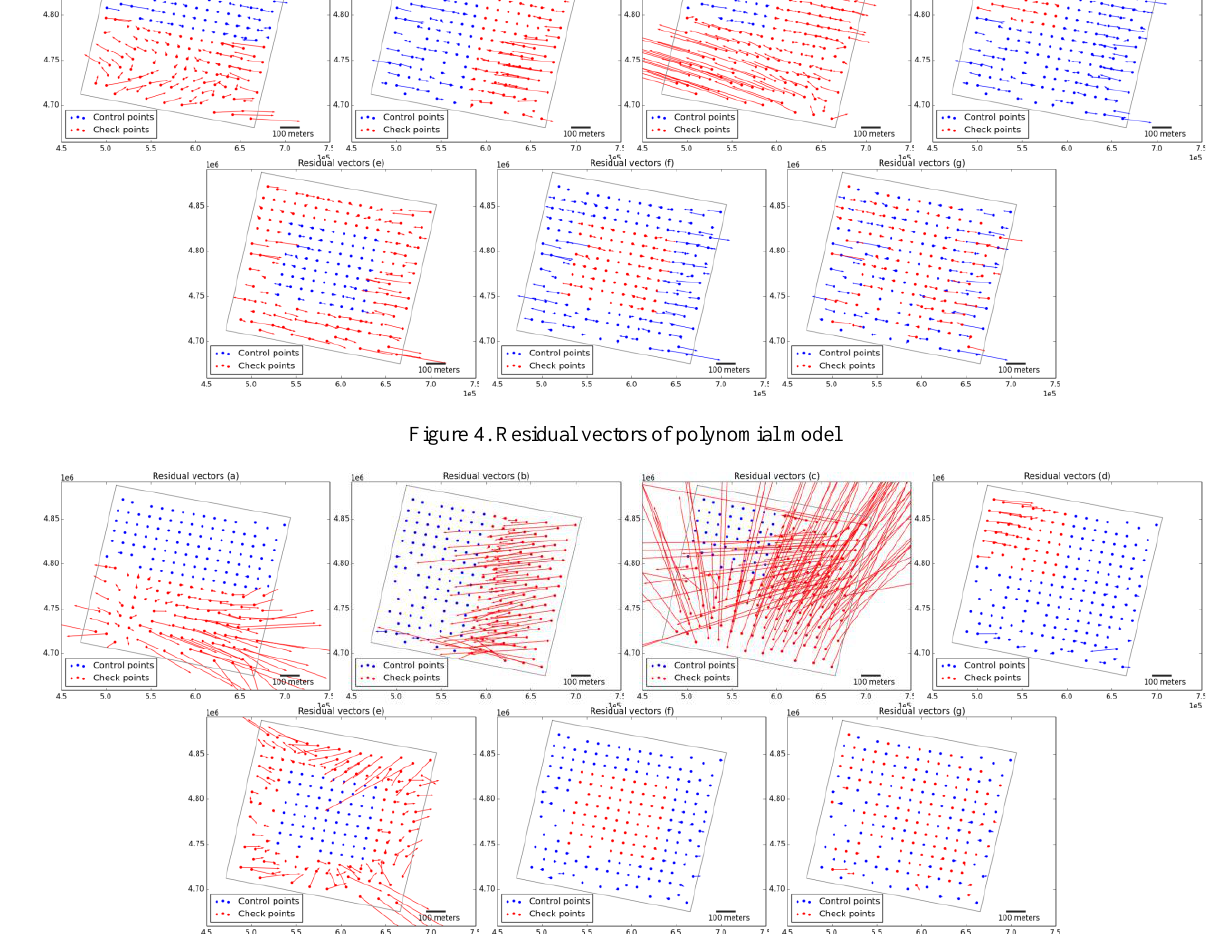
Figure 5. Residual vectors of rational function model (ridge